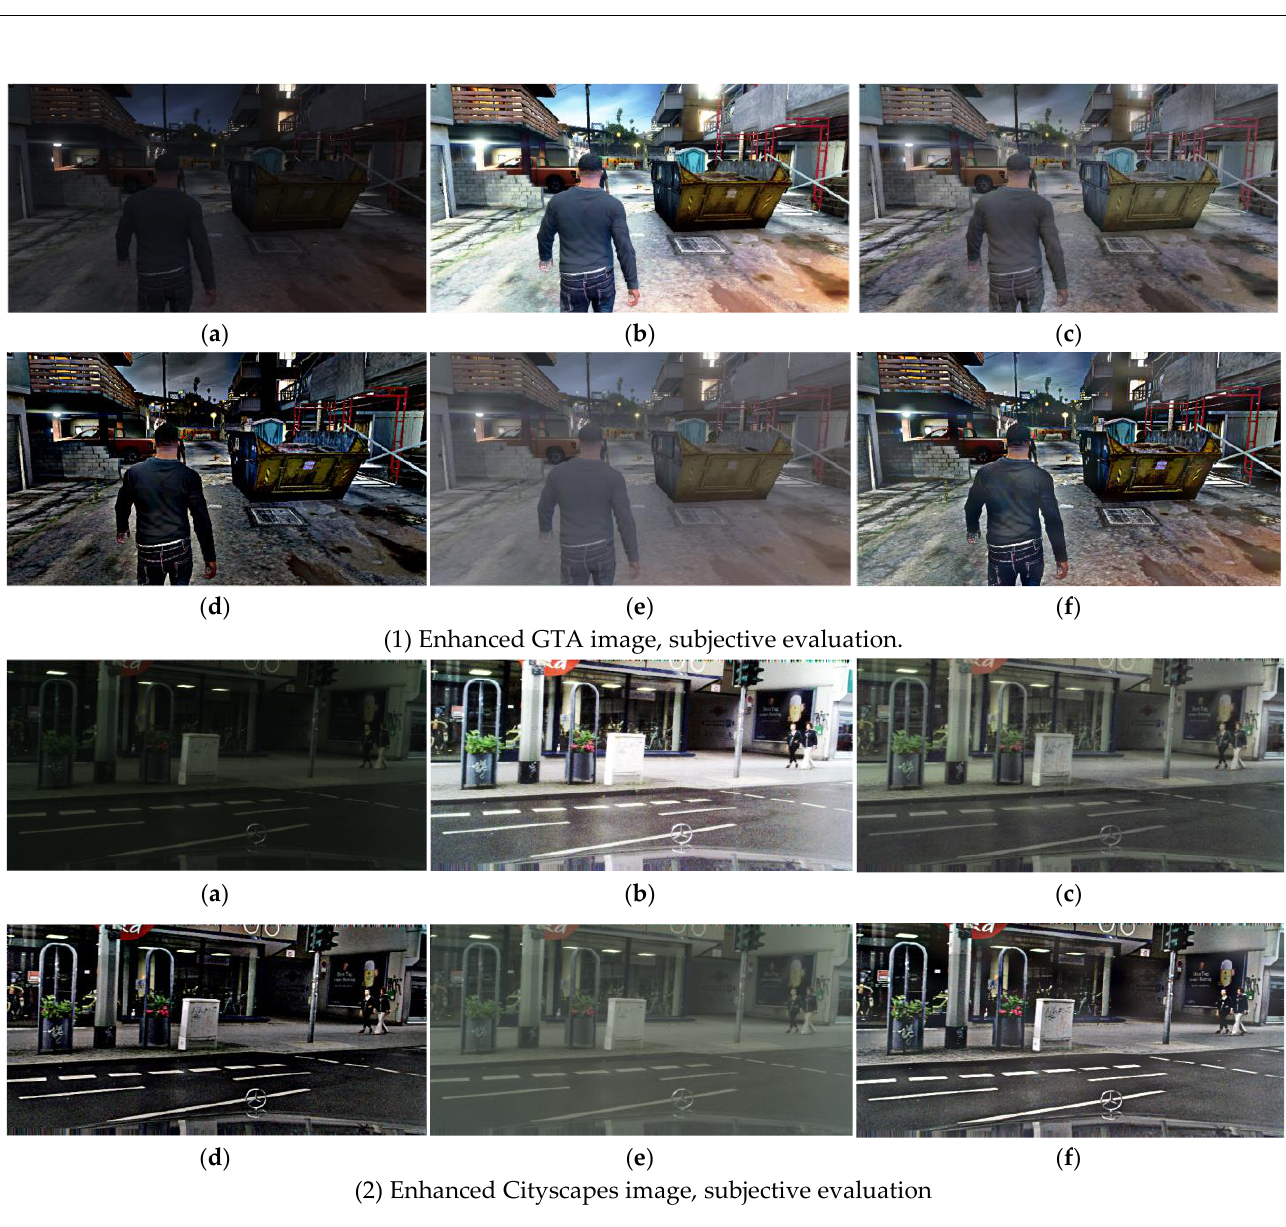
Figure 7. Results comparison: ( a ) original image; ( b ) HE; ( c ) CLAHE; ( d ) MSR; ( e ) GC; ( f ) HE-MSR-COM. The performance comparisons of different algorithms on the GTA5 dataset are shown in Table 3 and Figure 8. Table 3. Mean performance comparison in